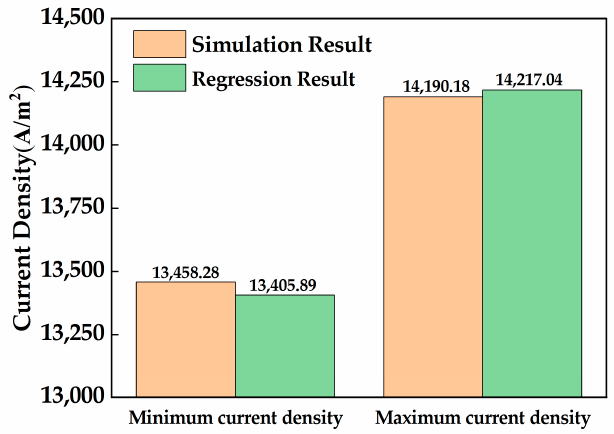
Figure 6. Regression and simulation results of the best combination and the worst combination of factors and levels.